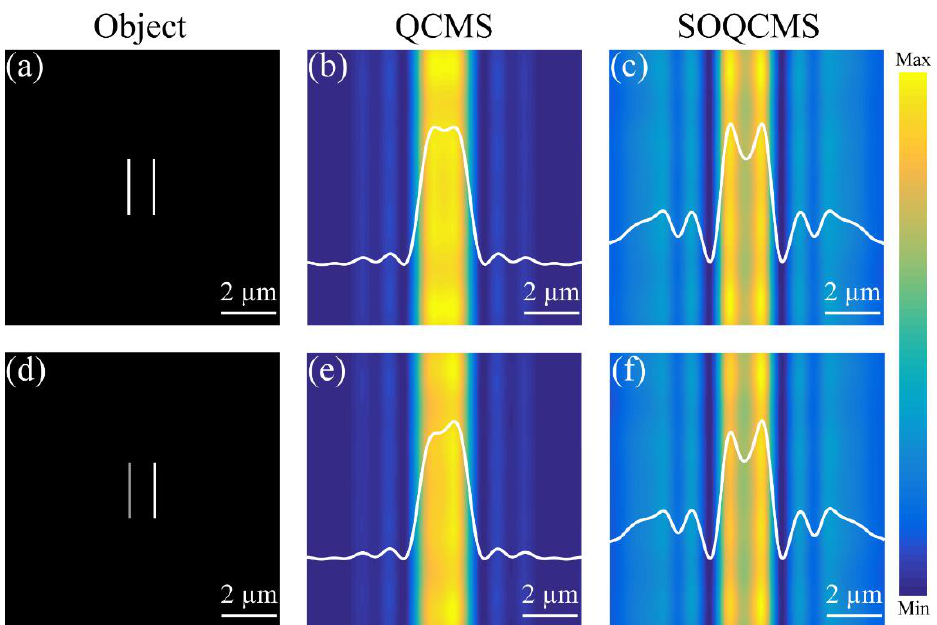
Figure 6. Simulated imaging results of two transparent equidistant slits with the same grayscales ( a ) and different grayscales ( d ) by employed QCMS ( b , e ) and SOQCMS ( c , f ), respectively. The white lines present the corresponding intensity curves. Both devices are illuminated under LCP light at the wavelength of 532 nm.